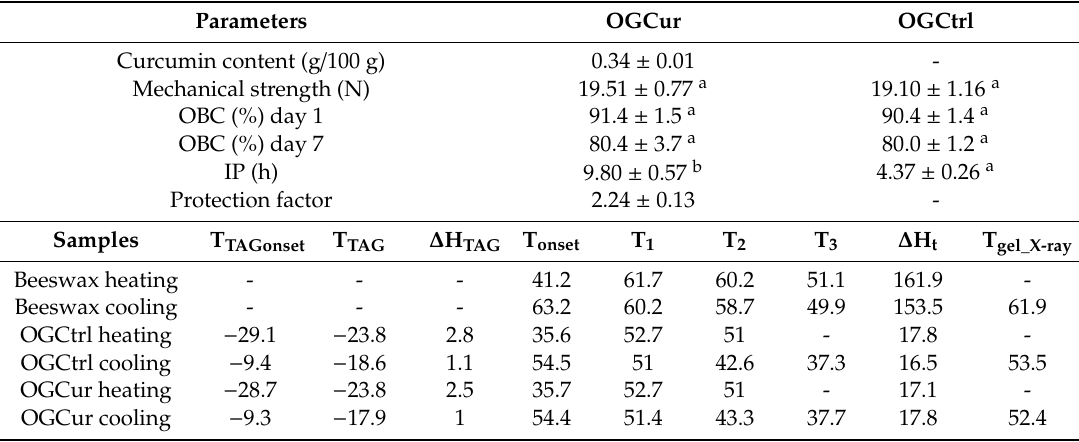
Table 1. Upper half: Characteristics of the linseed organogels with curcumin obtained under MSDC (total heat flow) data for beeswax, OGCur and OGCtrl from Figure